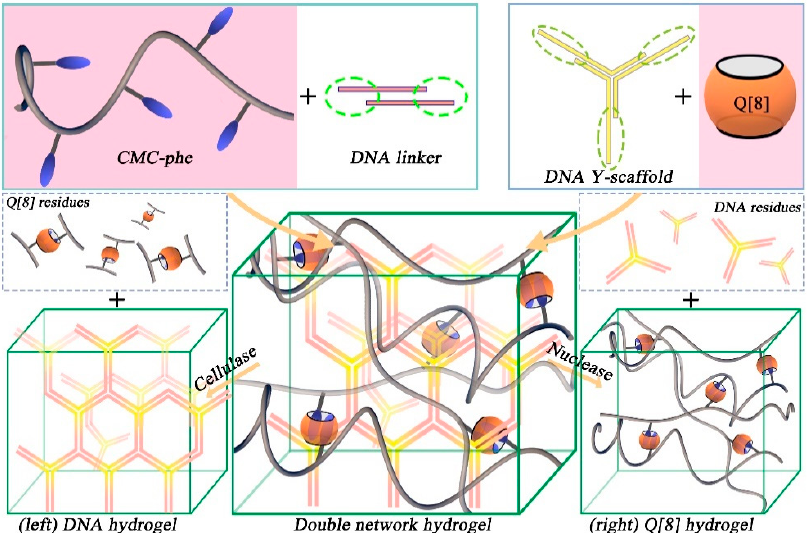
Figure 2. The formation process of double-network hydrogels through supramolecular interactions. The first network is cross-linked by the hybridization of DNA sticky ends (left); the second network is a 2:1 homoternary complexation of a phenylalanine unit pendant from carboxymethyl cellulose to Q[8] (right).